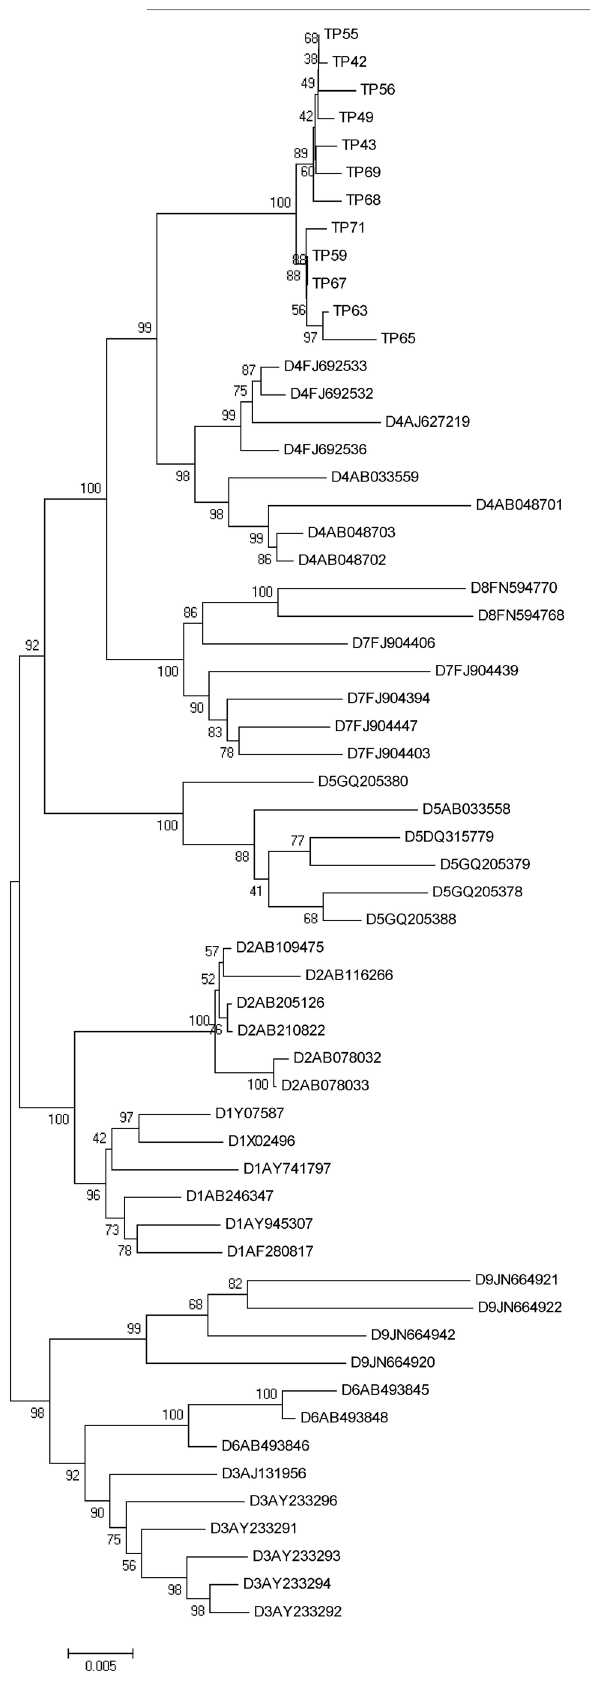
Figure 1. Phylogenetic tree of 12 Indian HBV strains belonging to subgenotype D4. The tree was formed on the basis of full-length HBV sequences. The reference sequences of different D-subgenotypes (D1-D9) retrieved from GenBank are indicated by their accession numbers. Indian HBV/D4 sequences of this present study are indicated by the respective isolate number beginning with